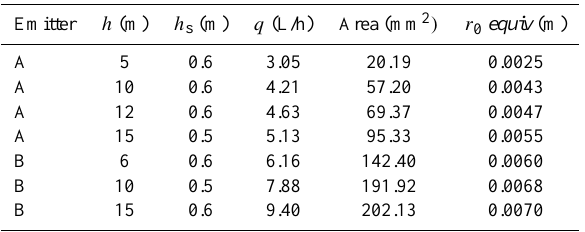
Fig. 2. Examples of developed cavities. (a) q = 4 . 21L/h; (b) q = 5 . 13L/h; (c) q = 7 . 88L/h. Table 3. Results of the tests.